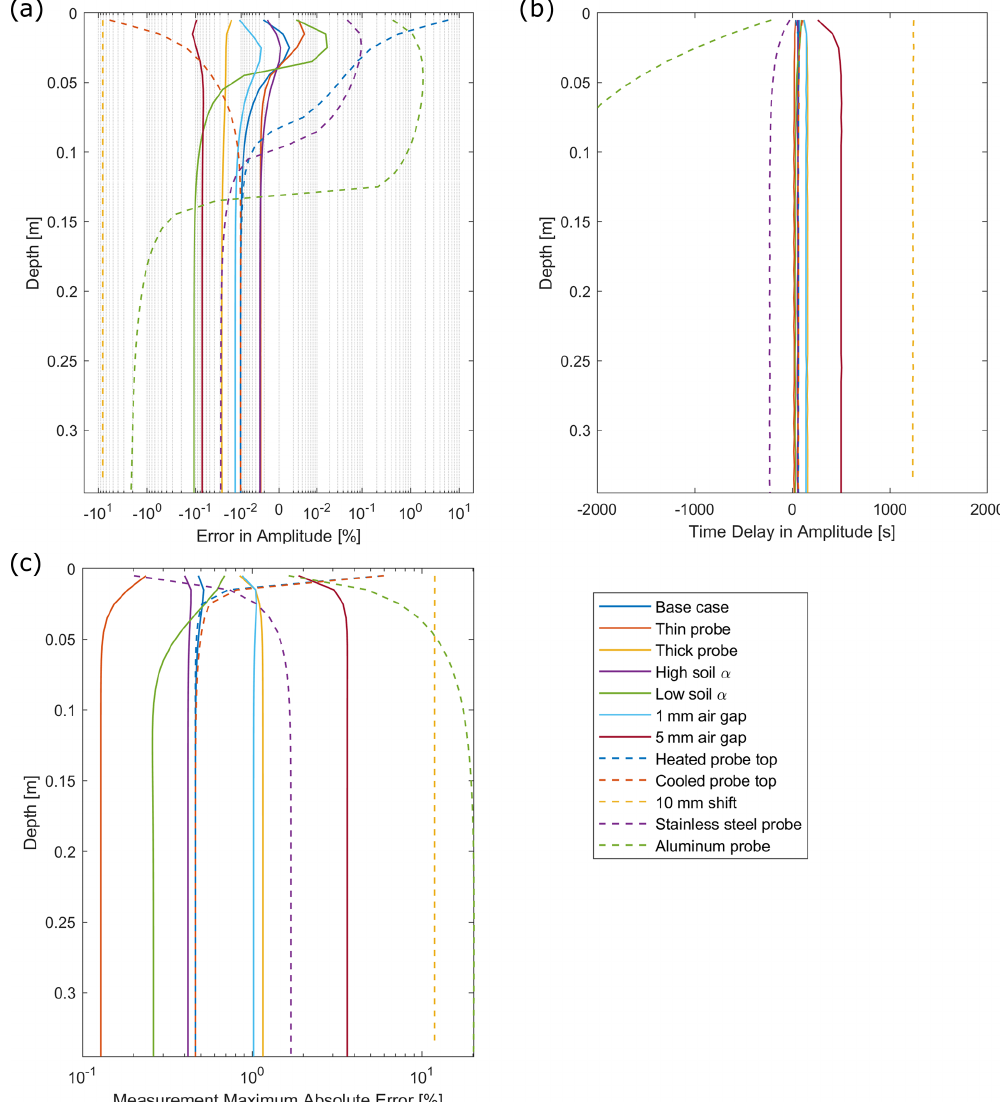
Figure 3. Influence of various probe characteristics and environmental factors on the accuracy of the DTP soil temperature measurements at various depth: (a) relative error in amplitude, (b) time delay in amplitude, and (c) measurement maximum percentage error relative to true amplitude at each depth.